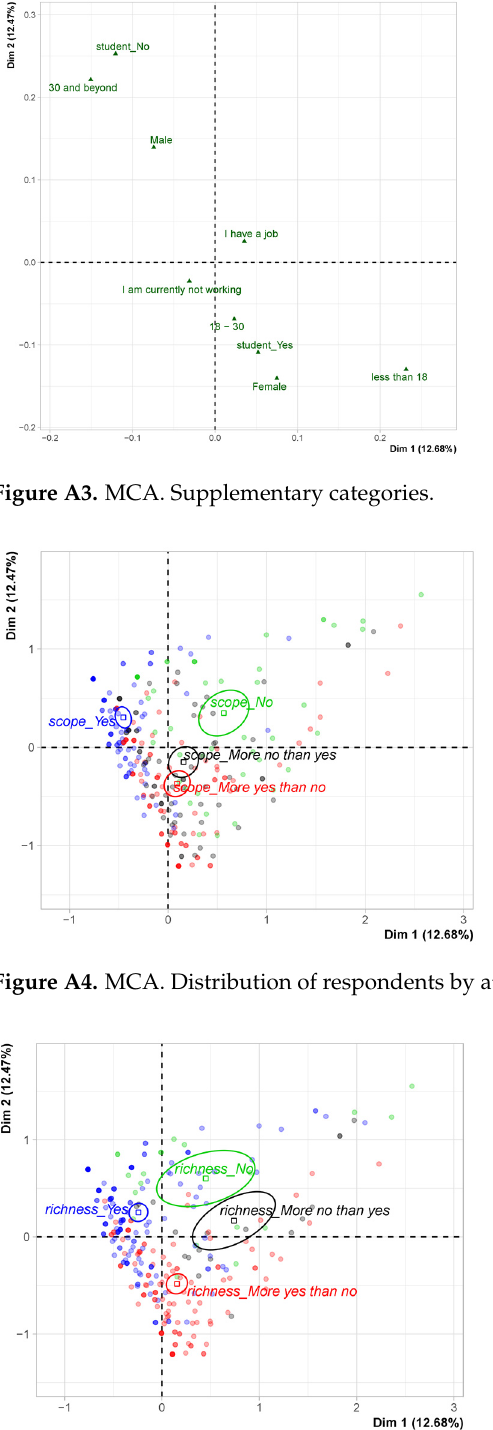
Figure A5. MCA. Distribution of respondents by attitudes towards increased job richness.